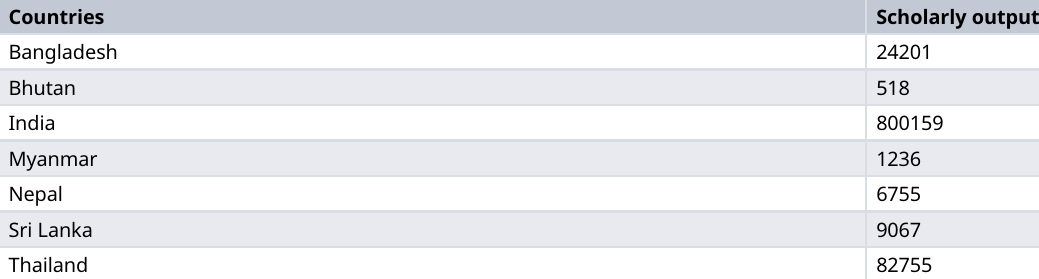
Table 1. Scholarly outcome in Scopus indexed publication for the years